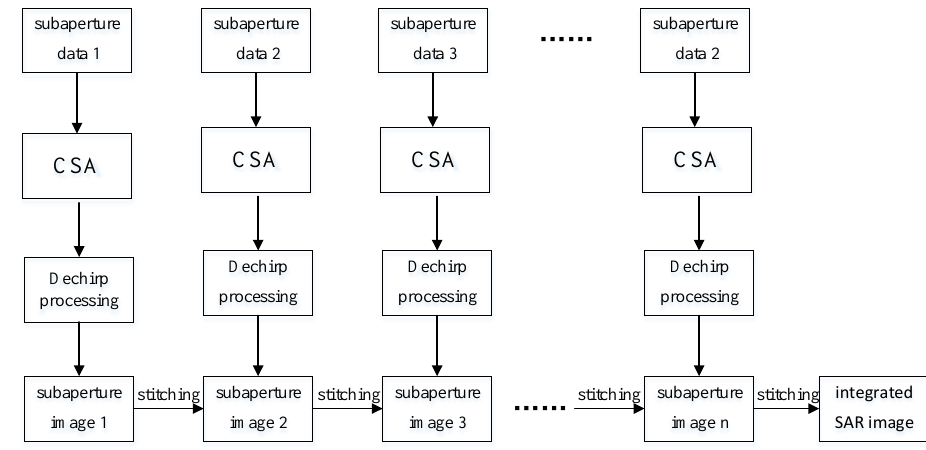
Figure 3. Flow chart of the real-time imaging algorithm.